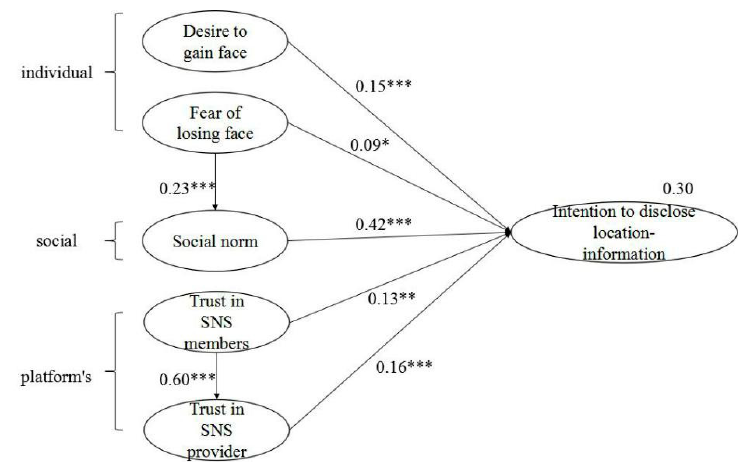
Figure 2. Path analysis results.